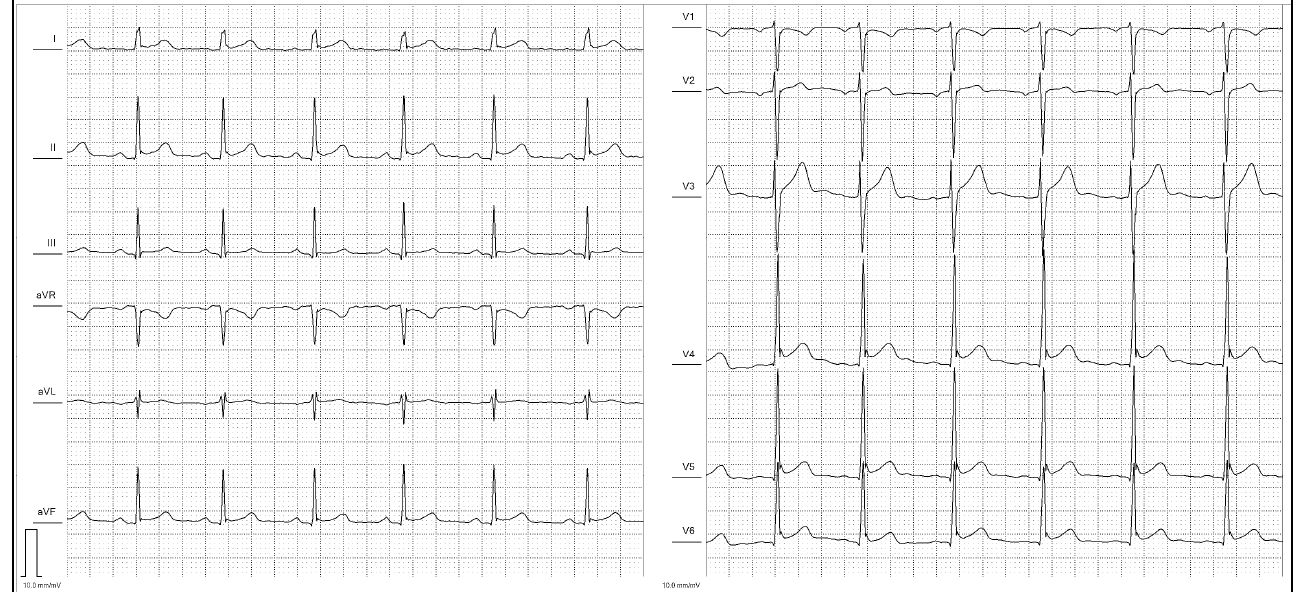
Figure 2. ECG with type 2 (notching at the end of QRS in the infero-lateral leads) ERP pattern and fQRS (I, aVL).